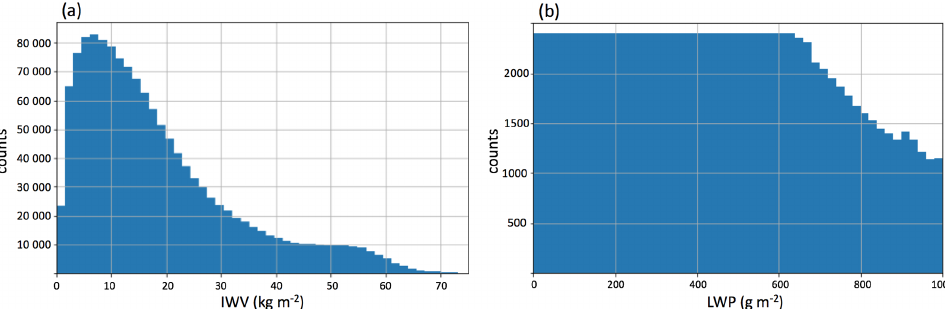
Figure 2. Distribution of the target variables (IWV and LWP in panels a and b , respectively) in the synthetic dataset after preprocessing.